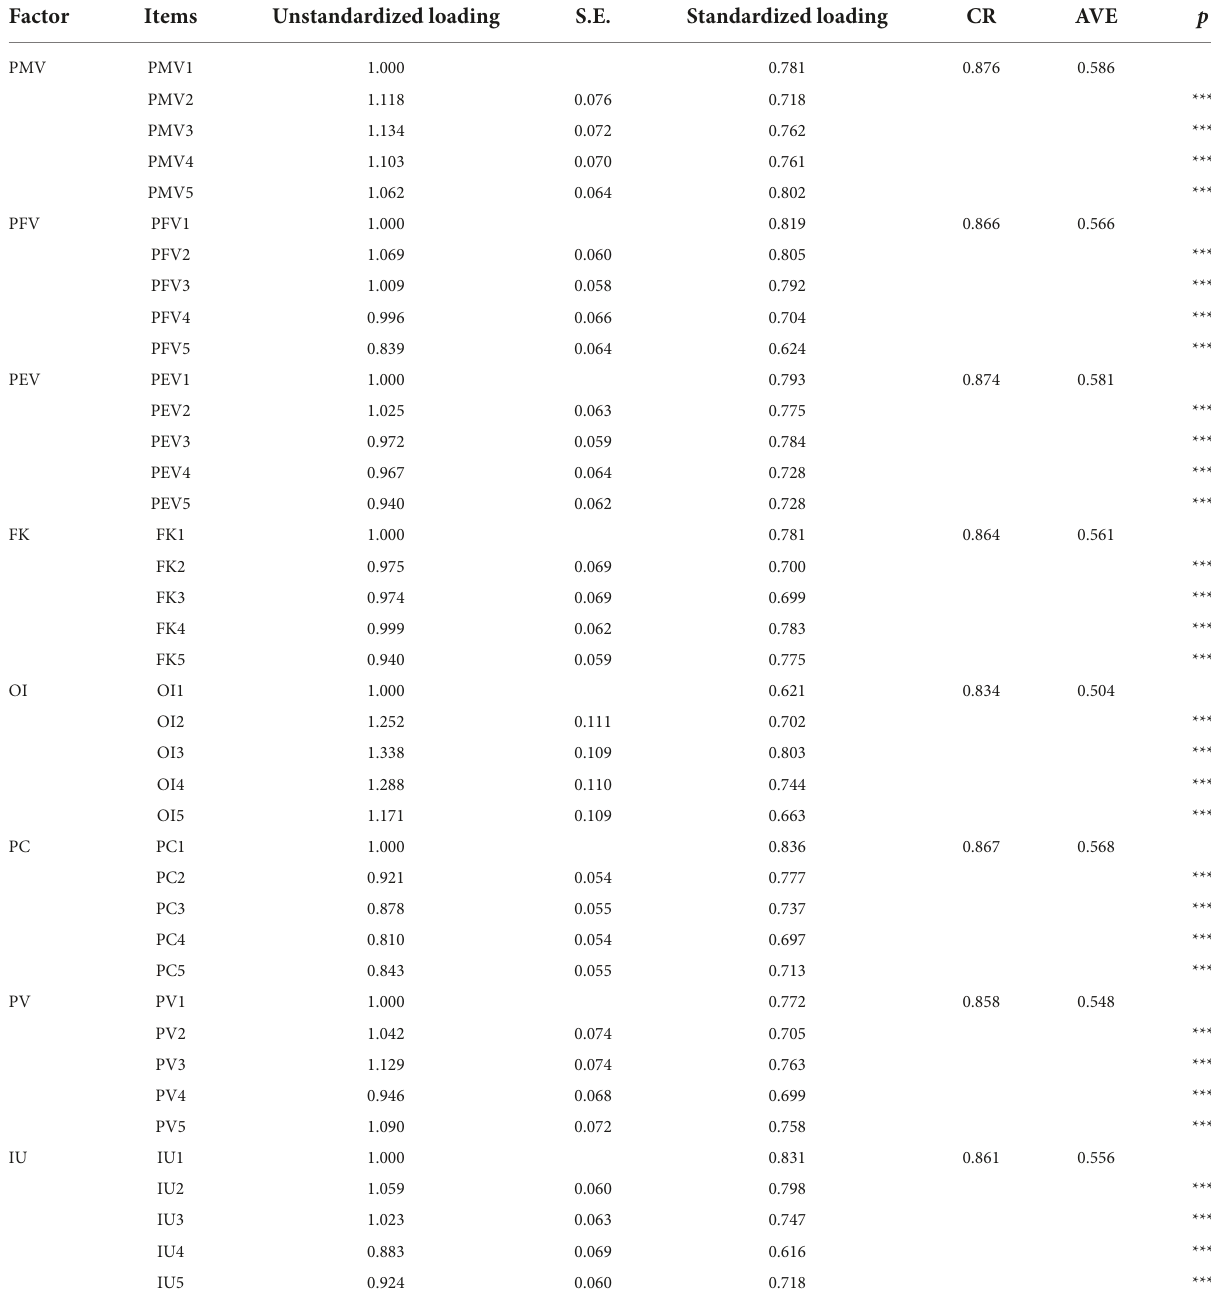
TABLE 3 Results of the confirmatory factor analysis.